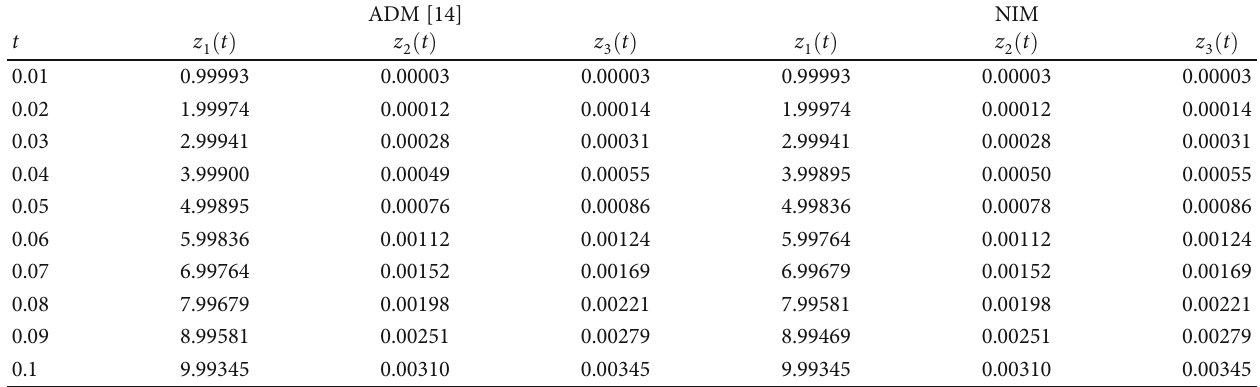
Table 1: Numerical comparisons between ADM and NIM for the impulse input model.